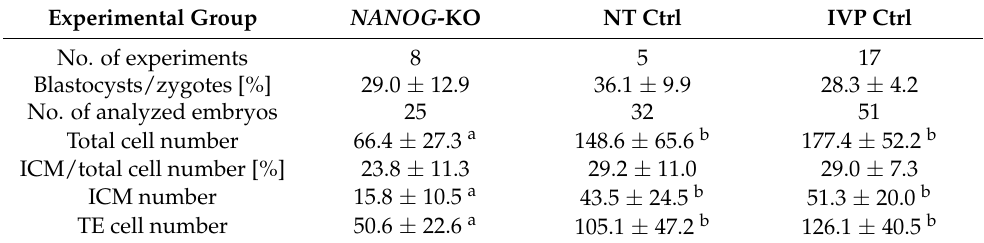
Table 1. Developmental rates and cell numbers of day 8 NANOG -knockout ( NANOG -KO), nuclear transfer control (NT Ctrl), and in vitro-produced control (IVP Ctrl) embryos. Data are presented as mean ± standard deviation. Different superscript letters (a, b) within a row indicate significant differences ( p < 0.05). Data were analyzed by Kruskal–Wallis test with Dunn’s multiple comparisons test as post hoc